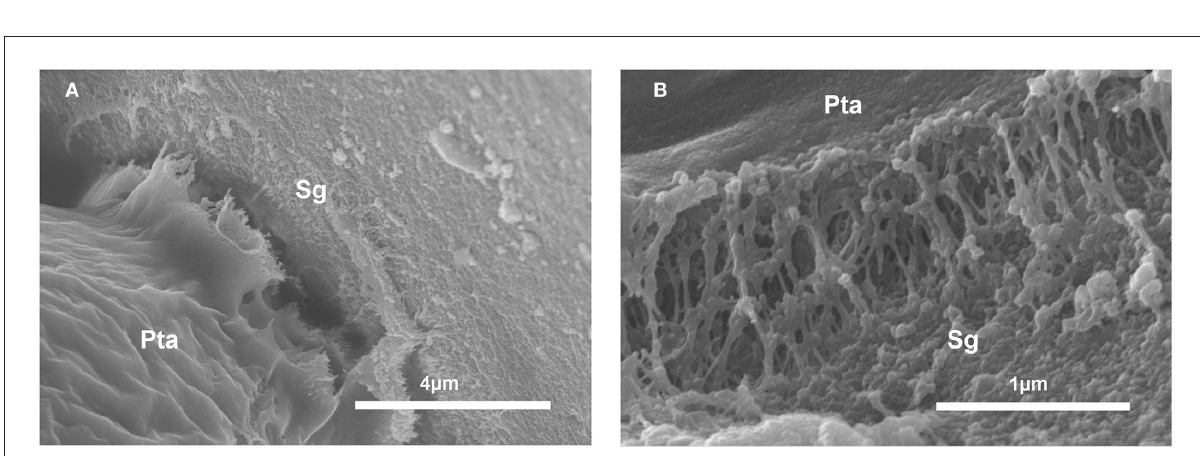
FIGURE3 Scanning electron micrographs of in vitro germination of Crocus pollen on Silica gel scales (Sg). (A) Note the protrusion from the tube apex (Pta) of a material resembling a secretion. (B) Interface tube-Silica scale showing a mucillaginous fibrillary material forming adhesive bridges between tube apex (Pta) and Silica